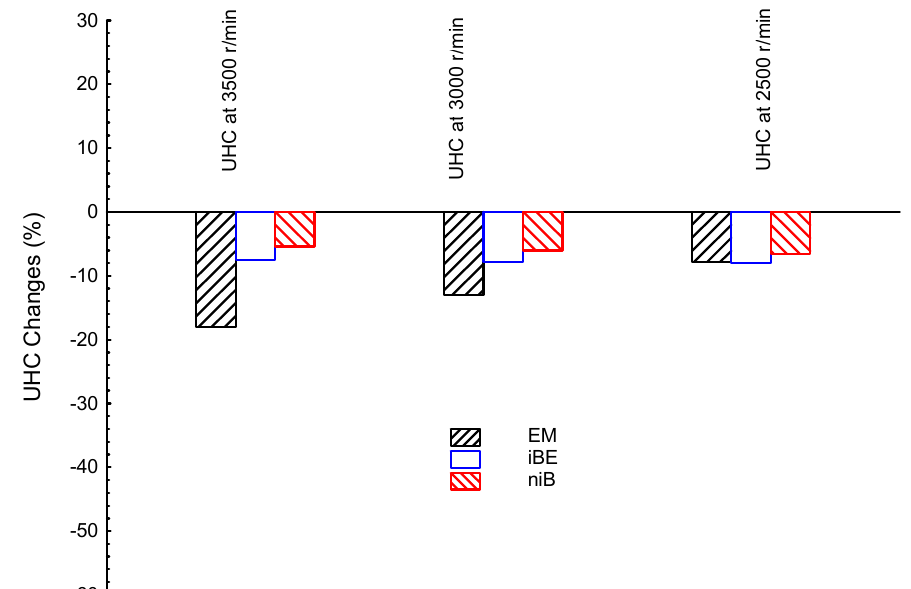
Figure 7. UHC emission at three different engine speeds (3500, 3000, and 2500 r/min) for ternary blended fuels of bio-ethanol–bio-methanol–gasoline (EM), iso-butanol–bio-ethanol–gasoline (iBE), and n-butanol–iso-butanol–gasoline (niB); gasoline is the reference line.